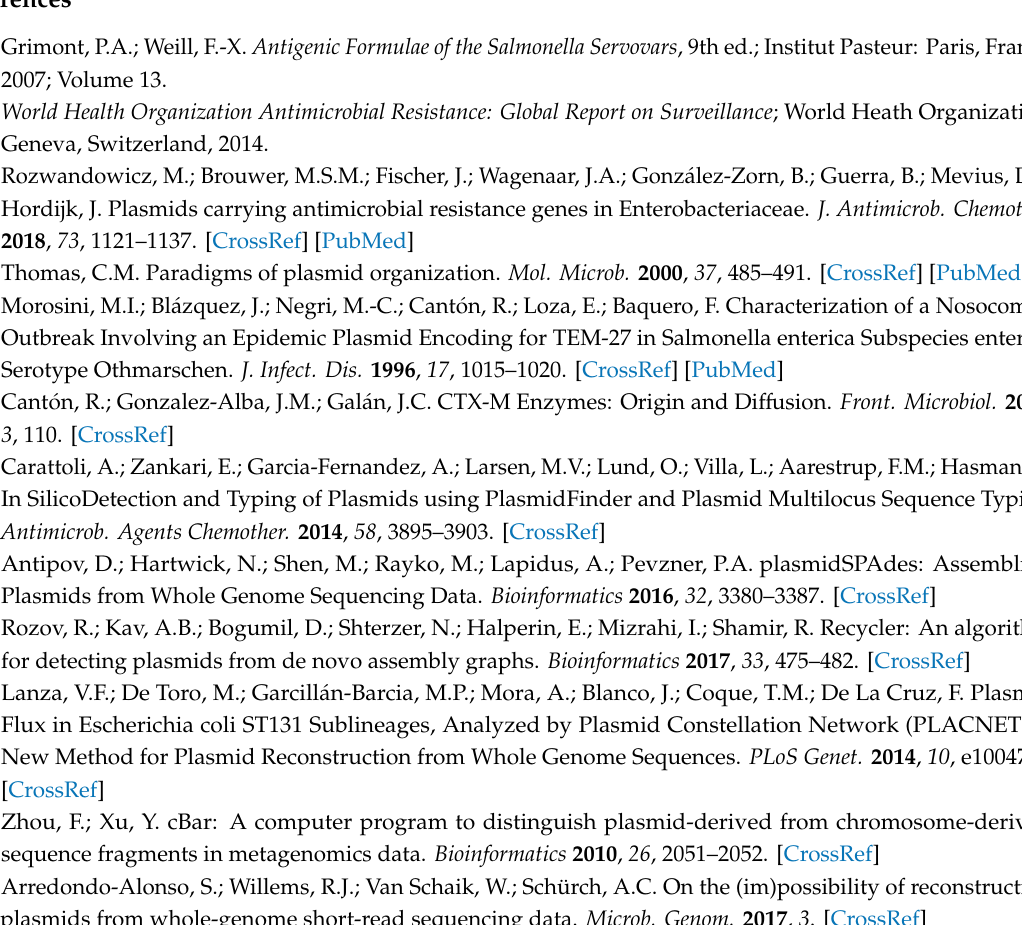
Table S1 : Isolates, Table S2: Serotypes, Table S3: Put. Plasmids, Table S4: Replicons Count, Table S5: AMR Profiles, Table S6: AMR Prelevance, Table S7: AMR Post-Recov, Table S8: AMR Chromosome, Table S9: Hybrid